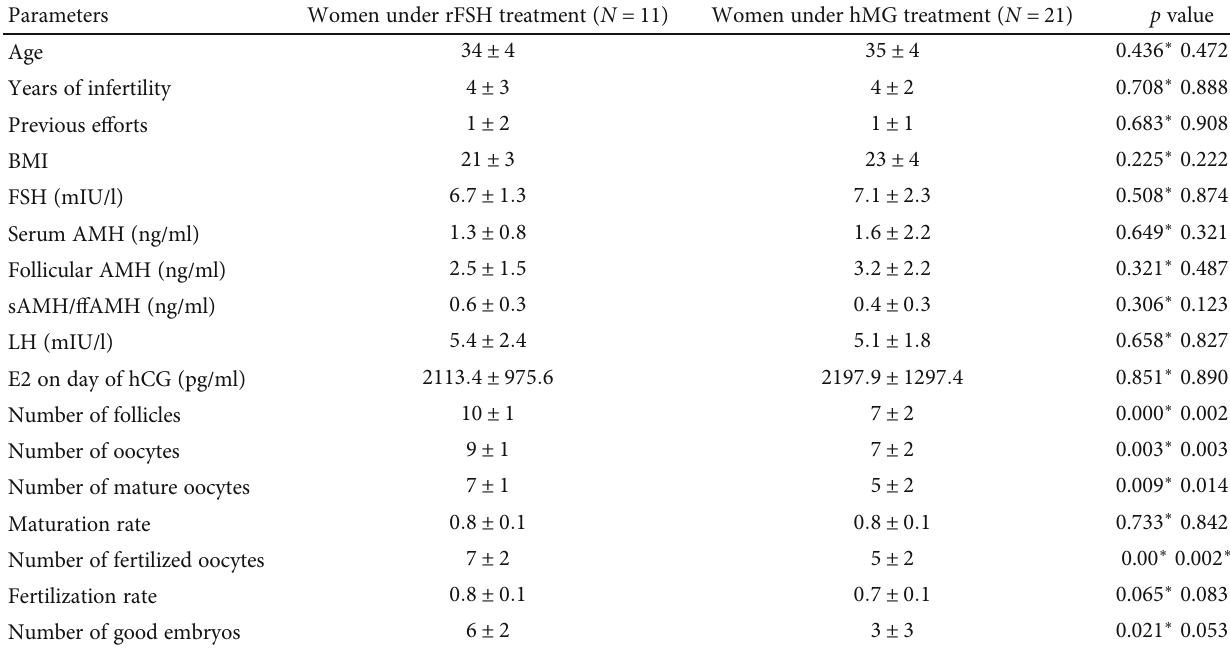
Table 4: Clinical and biochemical characteristics of women according to the gonadotropin regimens. For all data in the table, p values were calculated with both parametric ( t -test — ∗ ) and nonparametric tests (Mann-Whitney U — ∗∗ ).